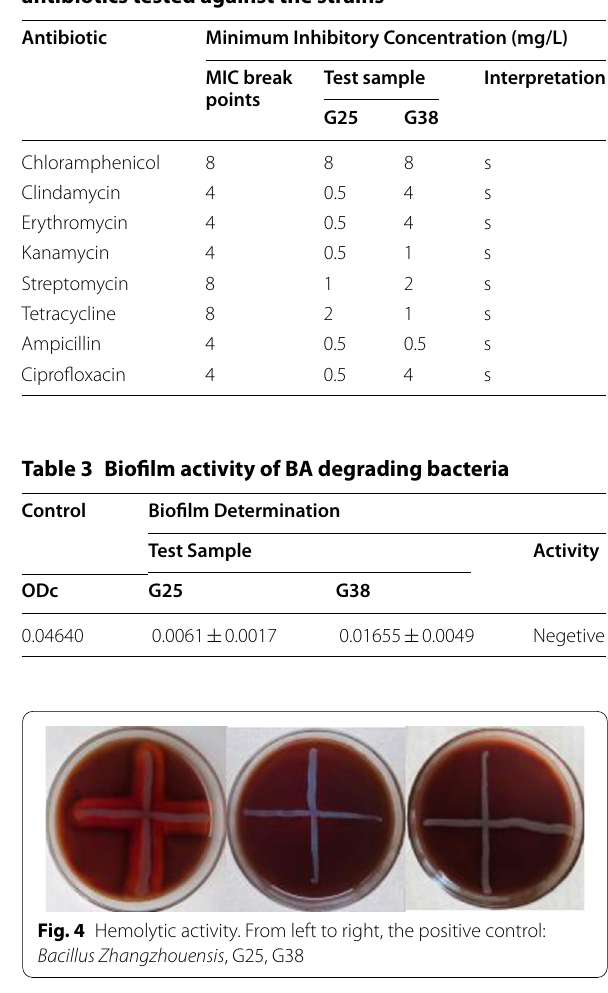
Table 2 Minimum inhibitory concentrations for eight